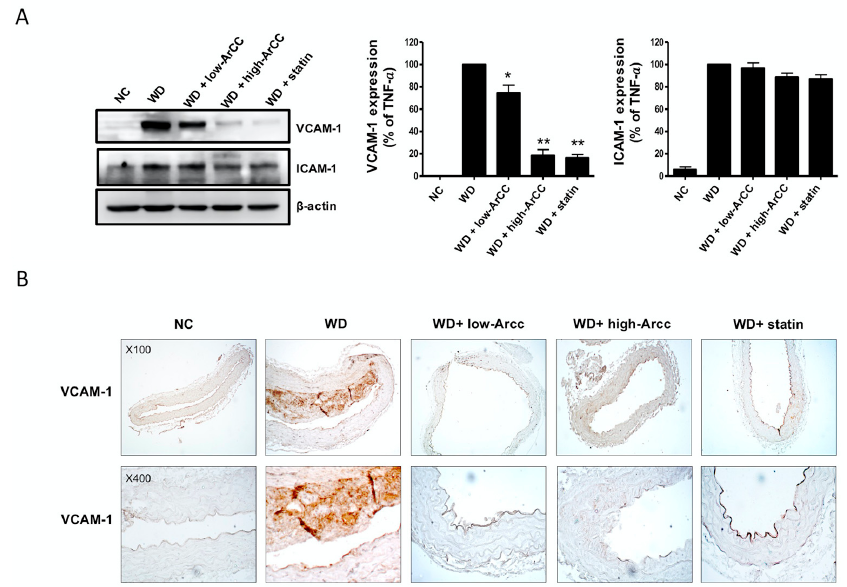
Figure 6. ArCC administration inhibits vascular inflammation of WD ApoE − / − mice. ( A ) Immunoblotting for VCAM-1 and ICAM-1 using lysates from whole aortas of western diet (WD)-fed ApoE − / − mice with ArCC treatment at the indicated conditions. β -actin was used as loading control. Relative changes in the expression levels were calculated based on densitometric scanning of each band. * p < 0.05, ** p < 0.01 versus WD as determined by one-way analysis of variance followed by Bonferroni’s multiple comparison tests. ( B ) Immunohistochemistry for VCAM-1 in the thoracic aorta of NC ApoE − / − mice, WD ApoE − / − mice, WD ApoE − / − mice with ArCC administration (low or high), and WD ApoE − / − mice with statin ( n = 4). The aortas were sectioned and stained with anti-VCAM-1 antibody. Sectioned aortas were counter-stained with hematoxylin (Magnification, 100× or 400×).